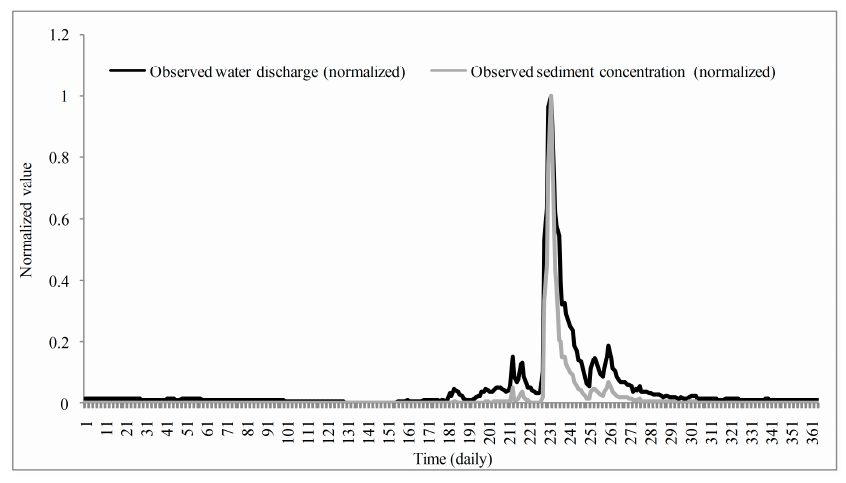
Figure 1. Plot showing relationship between sediment concentration and water discharge in the Ramganga River.